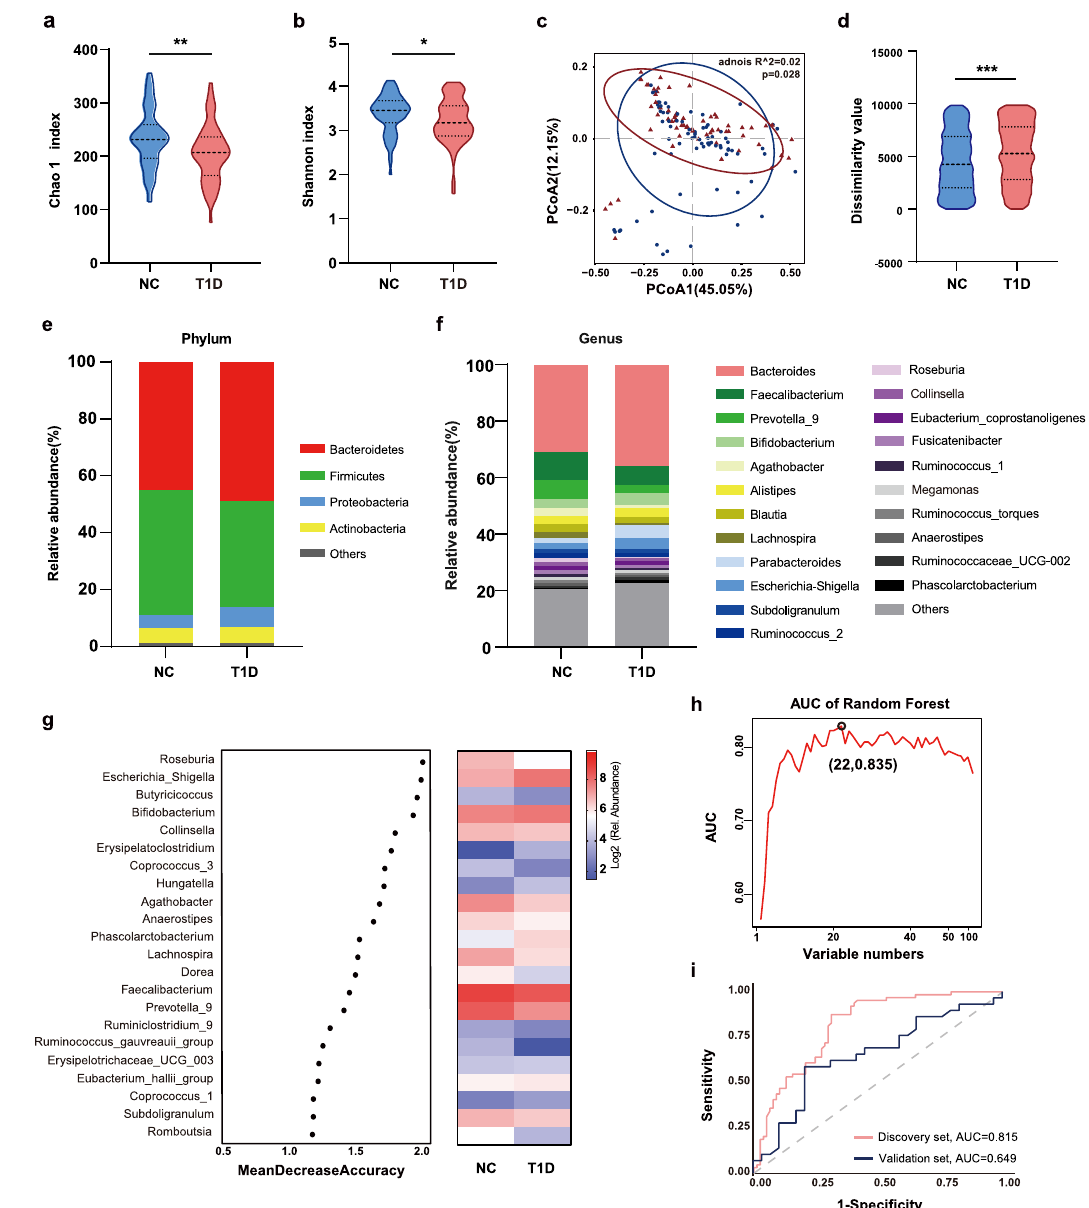
heatmapbasedontherelativeabundanceofthegenera. h Areaunderthecurve (AUC) based on the cross-validation of the random forest model in the dis- covery set. i Receiver operating characteristic (ROC) curves and their corre- sponding AUCs employing 22 genera in the discovery and validation sets. For thediscoveryset,NC: n = 77, T1D: n =64.Forthe validationset, NC: n = 29, T1D: n = 29. Violin plots show the median, quartiles, and min/maxvalues.